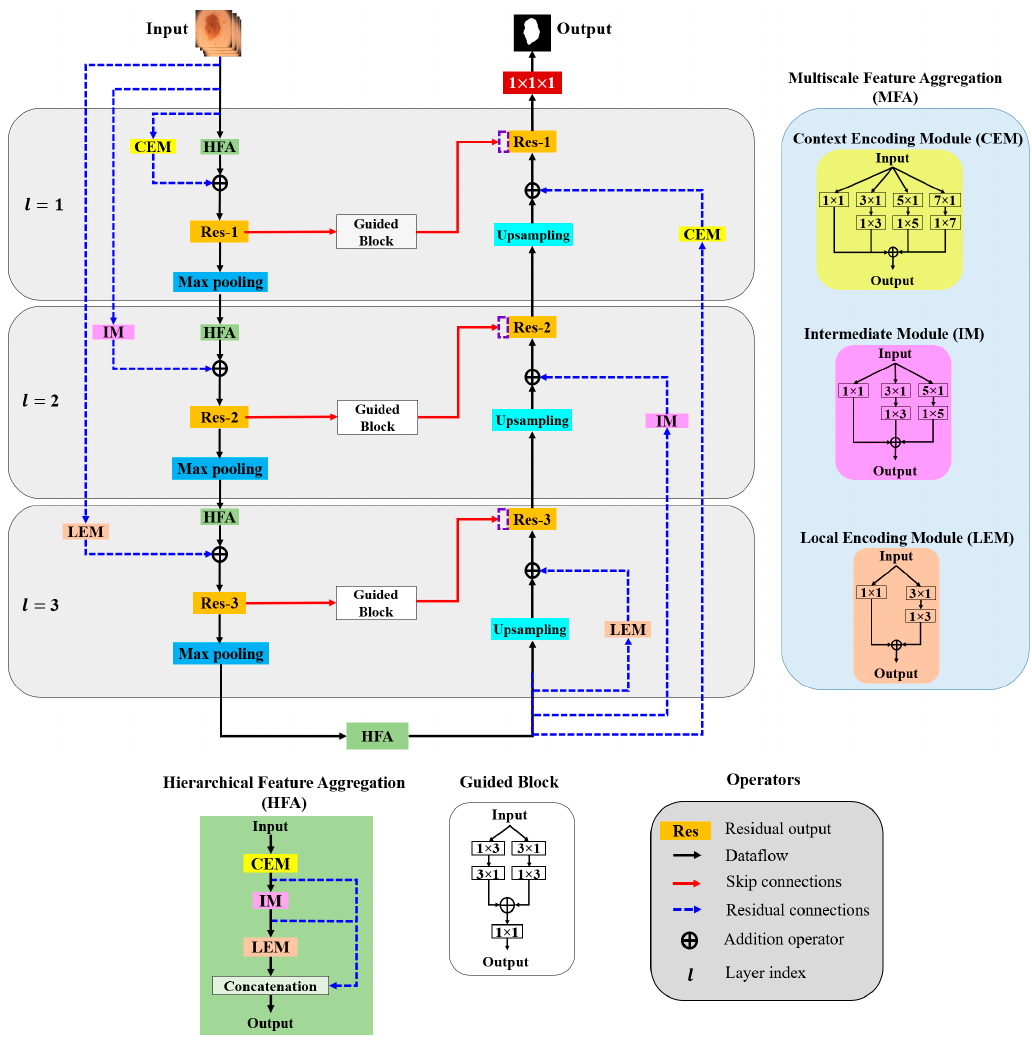
Figure 3. Overall architecture of the proposed model.